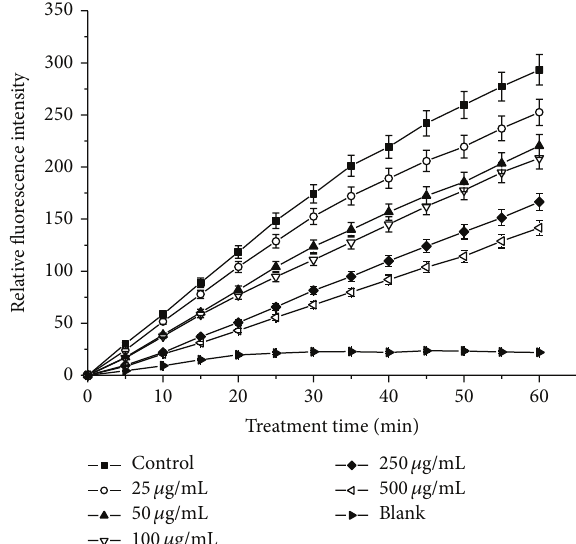
Figure 2: Intracellular radical scavenging activities of the purified flavonoid extract from leaves of Juglans regia L. in RAW264.7 cells. Data are reported as the mean ± SD of three